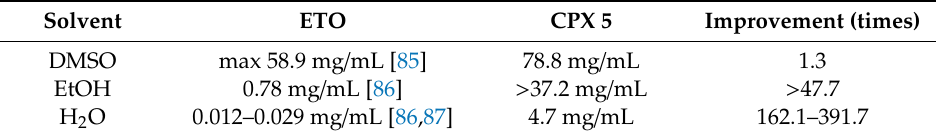
Table 4. Comparison between solubility of free ETO and ETO-loaded CPX 5